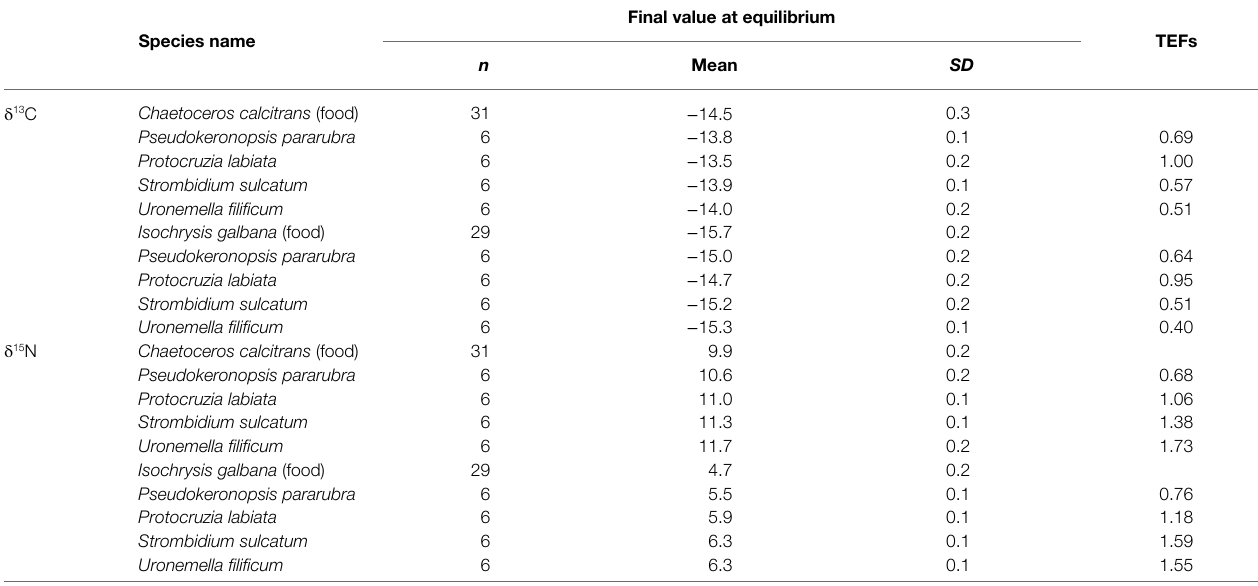
TABLE 4 | Trophic enrichment factors (TEFs, Δ 13 C, and Δ 15 N) of marine ciliates ( Pseudokeronopsis pararubra , Protocruzia labiata , Strombidium sulcatum , and Uronemella filificum ) fed with Chaetoceros calcitrans and Isochrysis galbana calculated from the equilibrium equation (Fry, 2006).